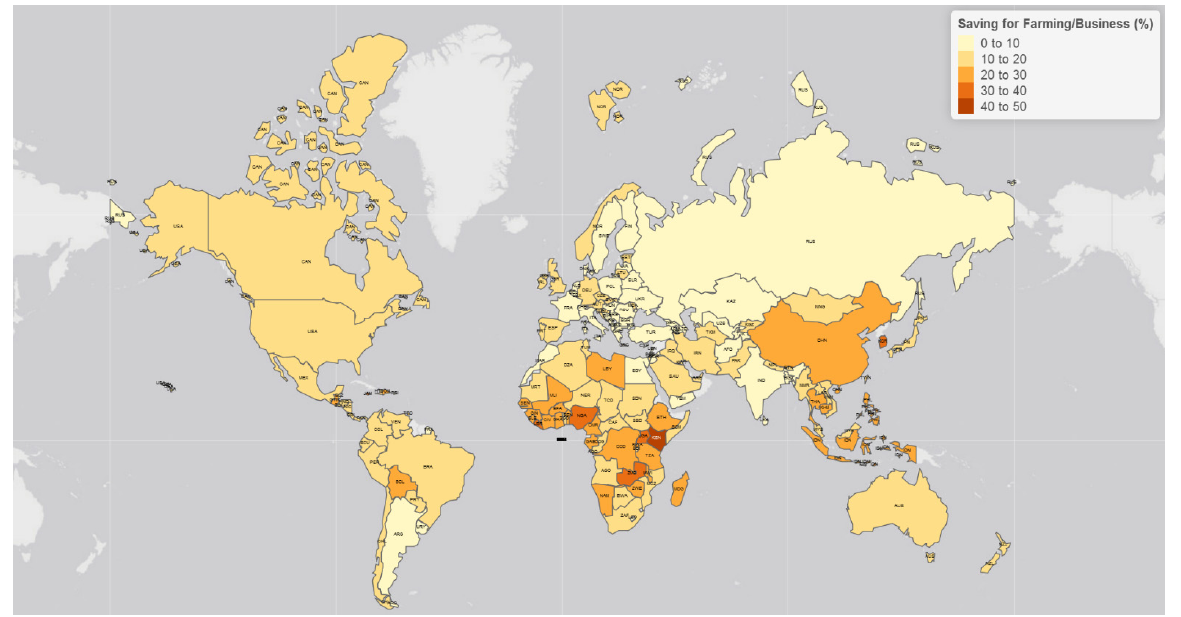
Figure A3. Country level weighted proportion of savers for entrepreneurial (farming or business) purposes between 2014 and 2017, globally. Source: Author’s own construction using the global financial inclusion surveys (2014 and 2017). (See dynamic web link at https://rpubs.com/brassbe1982/